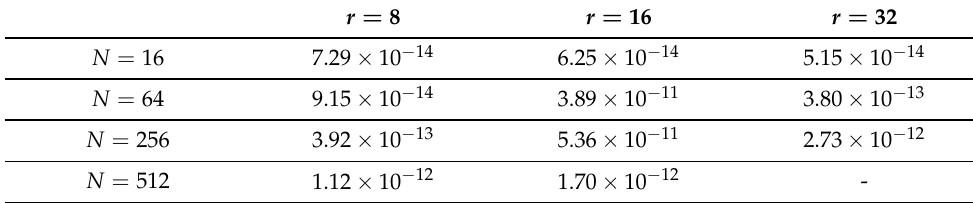
Table 5. The maximum relative errors of eigenvalues computed by Algorithm